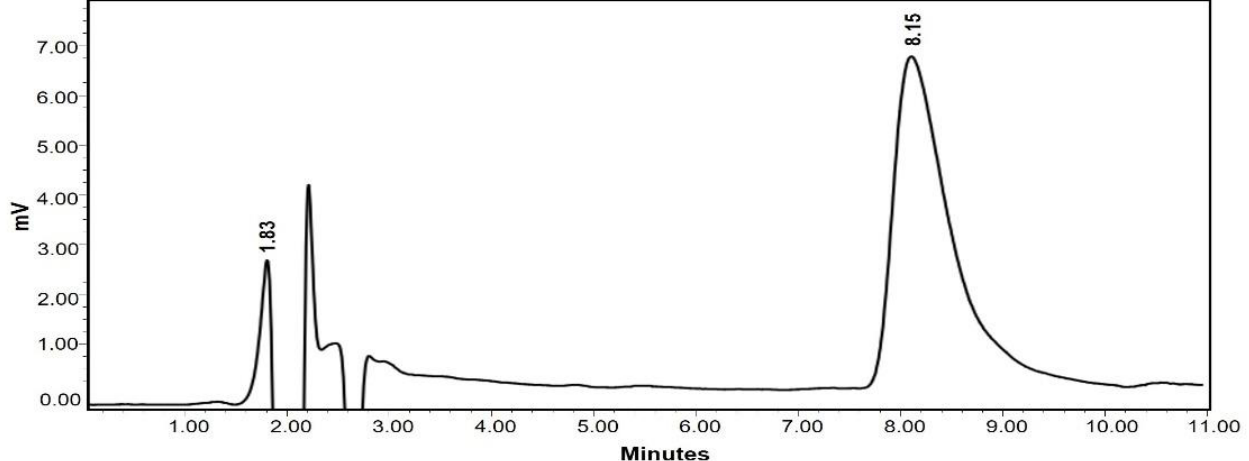
Figure 3. HPLC-PDA chromatogram of a quality control sample of acetyl hexapeptide-8 prepared in water/acetonitrile (30:70, v/v ) at 25 μg mL −1 . Chromatographic conditions: ΒΕΗ ΧBridge ® -HILIC analytical column; mobile phase: 40 mM ammonium formate aqueous solution/acetonitrile (30:70, v/v ), flow rate 0.25 mL min −1 at 214 nm.